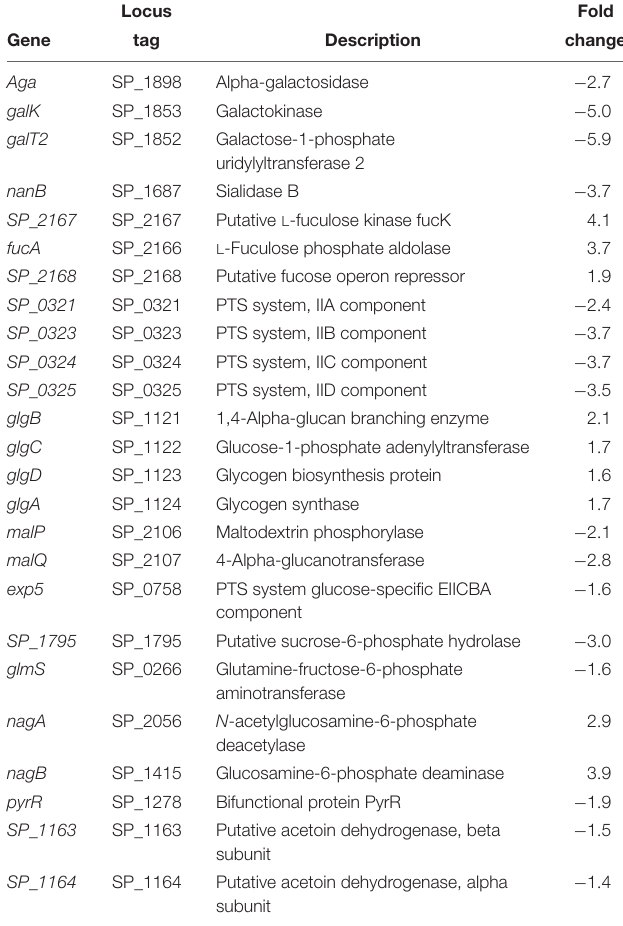
TABLE 1 | Differentially expressed genes in (cid:49) cadA from capsule biosynthesis